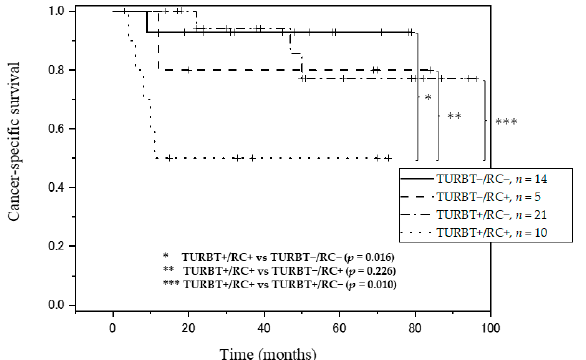
Figure 2. Kaplan-Meier curves for cancer-specific survival in all combinations of LVI at first TURBT and RC. Cancer-specific survival in * TURBT+/RC+ vs TURBT − /RC − ( p = 0.016), ** TURBT+/RC+ vs TURBT − /RC+ ( p = 0.226), *** TURBT+/RC+ vs TURBT+RC − ( p = 0.010). LVI: lymphovascular invasion; TURBT: transurethral resection of bladder tumor; RC: radical cystectomy.